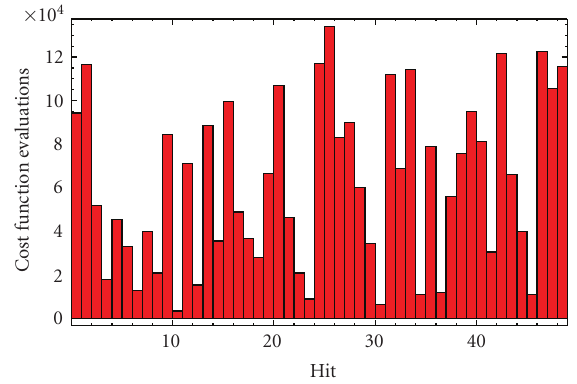
Figure 6: Histogram of SOMA